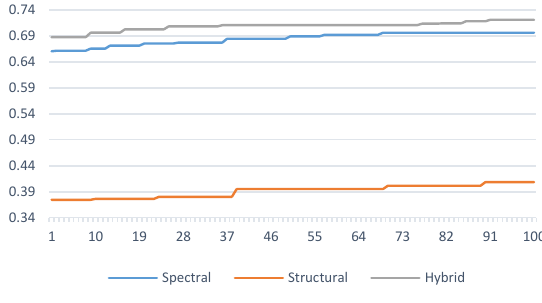
Figure 3. Convergence plot of the fitness value